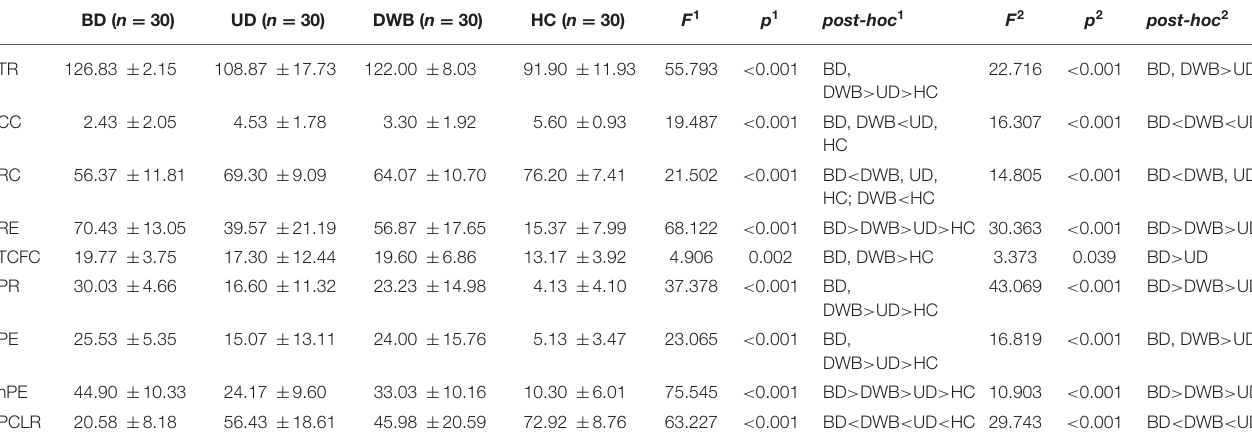
TABLE 3 | Comparison of WCST among patients with bipolar depression, unipolar depression, depression with bipolarity, and healthy controls (mean ± SD). BD ( n = 30) UD ( n = 30) DWB ( n = 30) HC ( n = 30) F 1 p 1 post-hoc 1 F 2 p 2 post-hoc